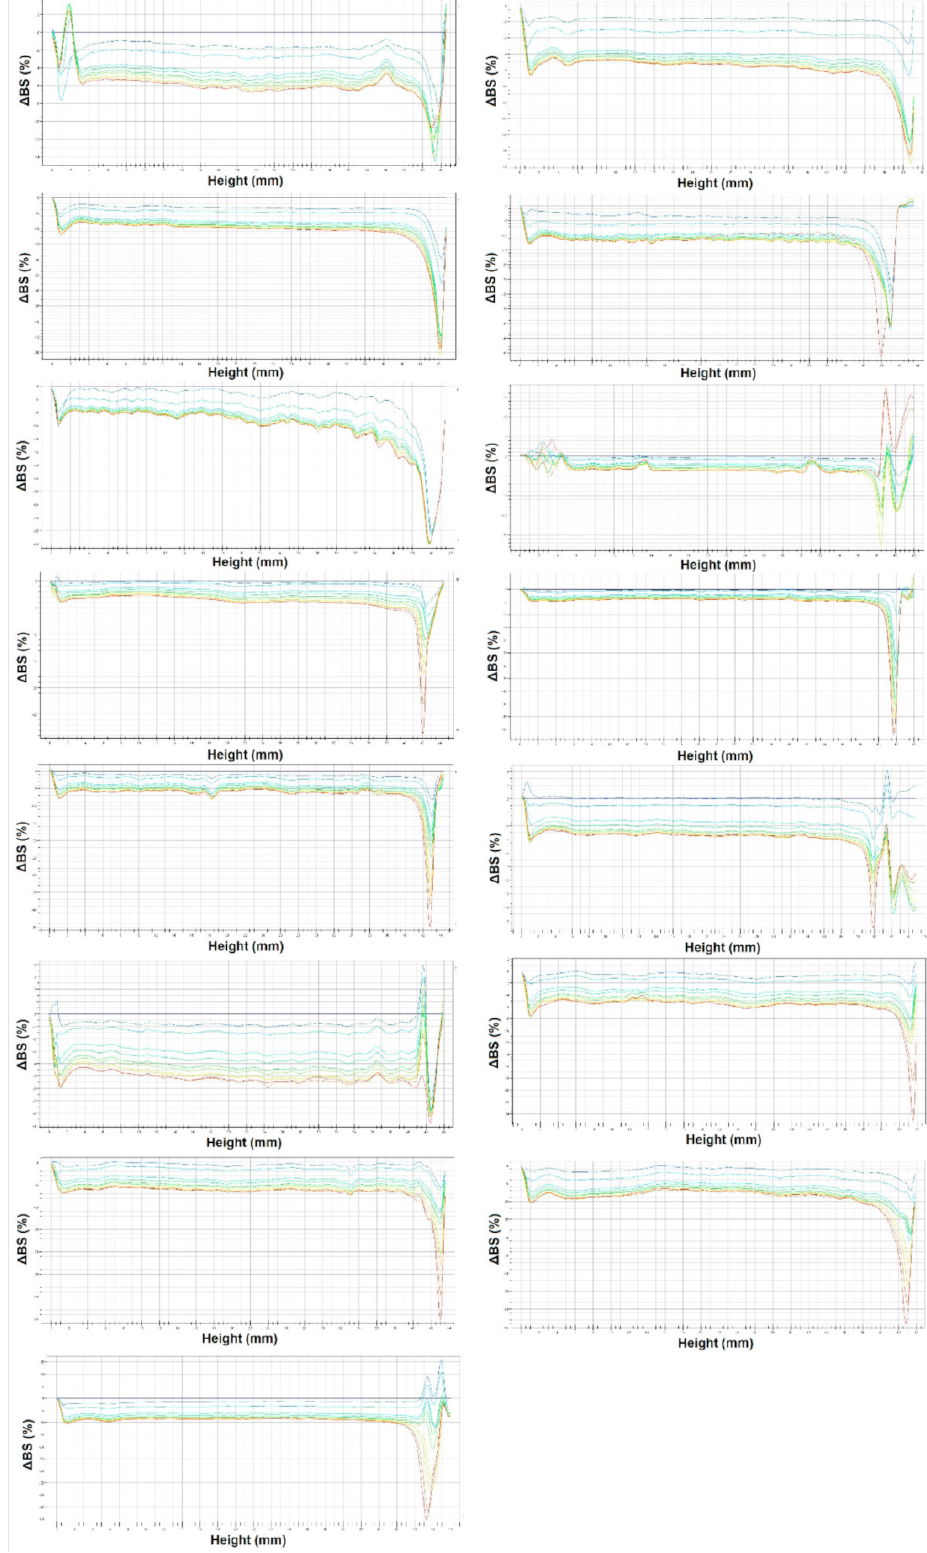
Figure 2. Change in intensity of back-scattered light ( ∆ BS) over time for emulsions I–XV. Blue line—first measurement, red line—last